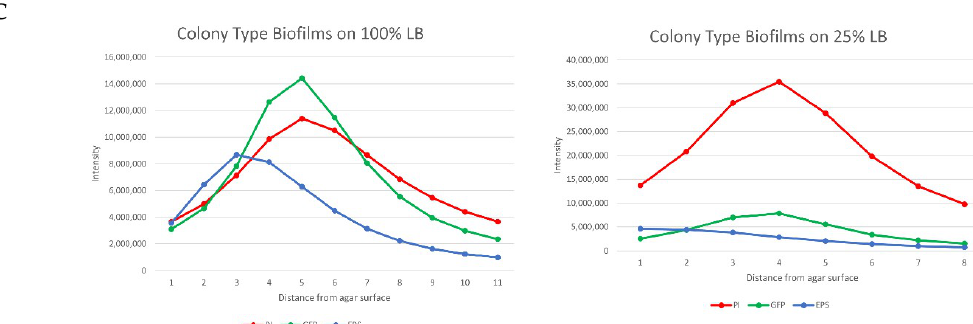
Figure 1. ( A ) OD measurement of B. subtilis cells grown under limited nutrient availability. 100% nutrient availability was achieved by medium containing 8 grams of LB per 400 mL of liquid (DDW). The graph curves, top to bottom, represent 8/5/4/3/2 grams of LB per 400 mL DDW, respectively. The results shown are means ± standard deviations (SD) of three independent experiments; ( B ) Confocal imaging of B. subtilis biofilm grown either under full (100% (2 g/100 mL), left column) or partial nutrient availability (25% (0.5 g/100 mL), right column). The following stains are shown: green fluorescent protein (GFP, live bacterial cells, second row), propidium iodide (PI, dead bacterial cells, third row), Alexa Fluor 647 (secreted exopolysaccharides, EPS, fourth row). Topmost row shows the combined images (i.e., GFP, PI and EPS); ( C ) Live/dead + EPS depth analysis of confocal images.